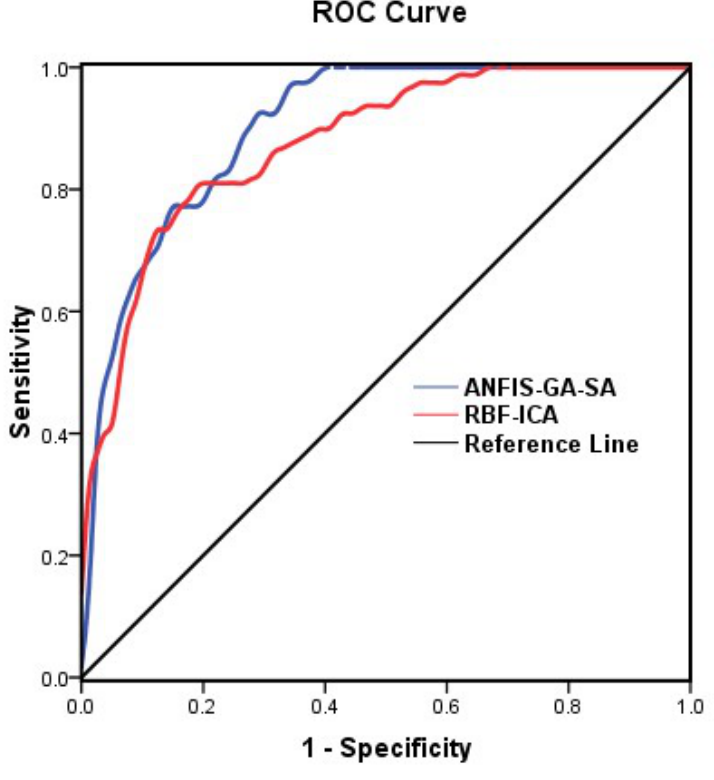
Table 8. Result of the validation parameters.